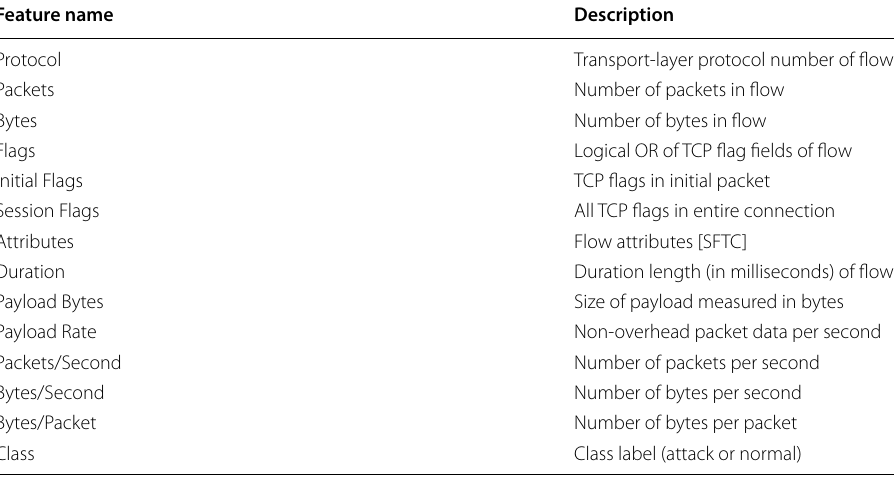
Table 1 Description of selected Netflow